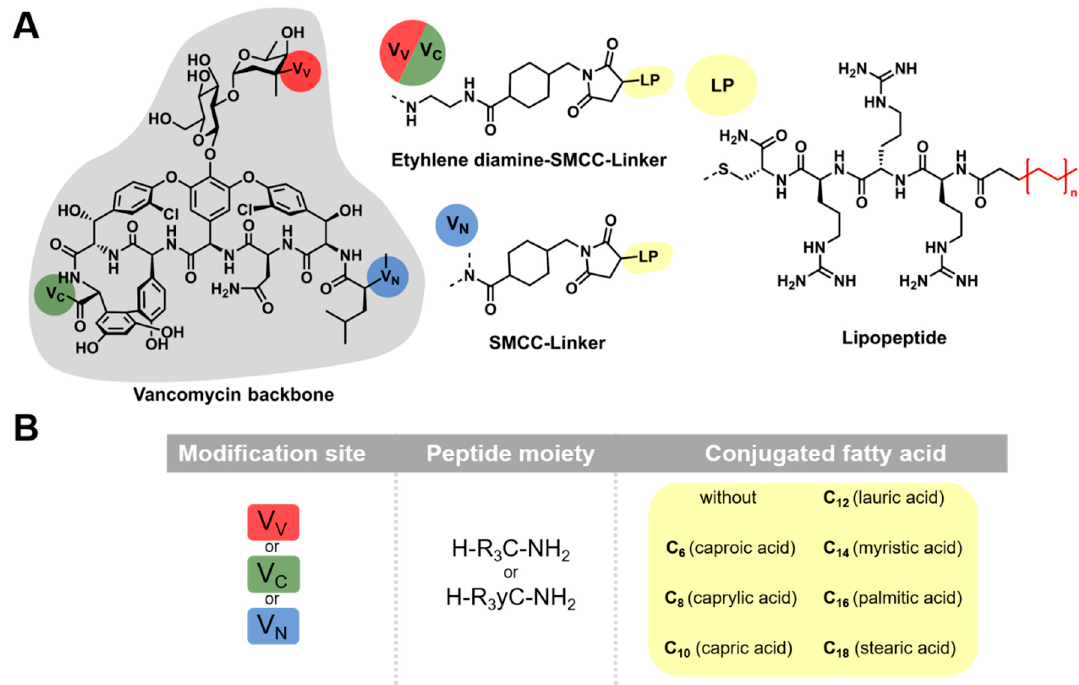
Figure 1. Schematic illustration of vancomycin-lipopeptide conjugates. ( A ) Three di ff erent modification sites of vancomycin were addressed. The primary amine position V V (red) and the carboxylic acid position V C (green) were extended by a combination of ethylene diamine and the heterobifunctional crosslinker succinimidyl 4-( N -maleimidomethyl)cyclohexane-1-carboxylate (SMCC). The secondary amine position V N (blue) was extended with SMCC only. The maleimide function of SMCC enables the coupling of cysteine-containing lipopeptides (LP, yellow) via thiol maleimide Michael addition. For this coupling, peptide sequences containing cysteine (C) and tri-arginine (R 3 ), combined with saturated fatty acids of varying chain lengths, were used. ( B ) Nomenclature of the generated conjugates. Conjugates are always designated in the described order: modification site (V V , V C , and V N )—peptide moiety (one-letter notation)—conjugated fatty